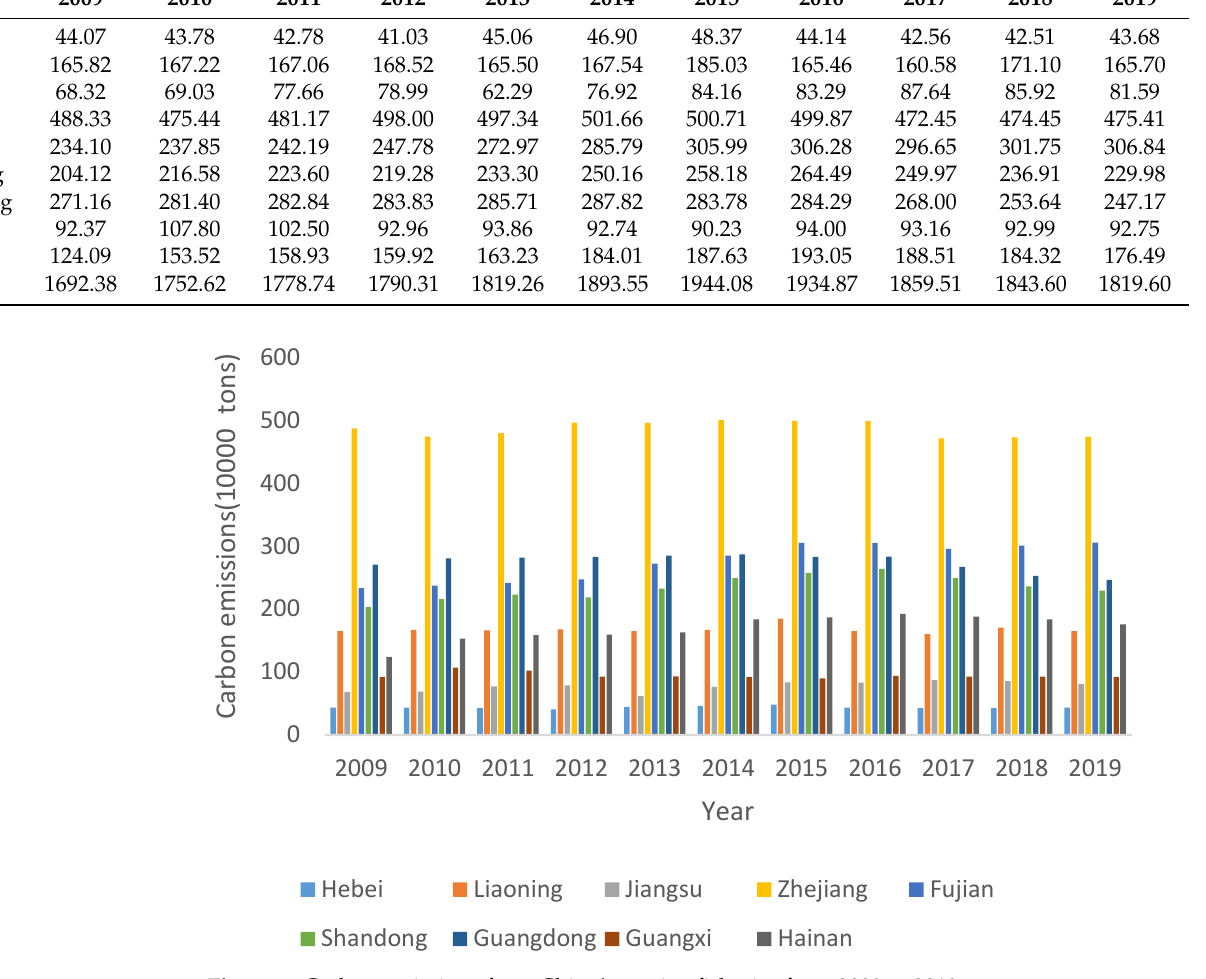
Figure 2. Carbon emissions from China’s marine fisheries from 2009 to 2019.